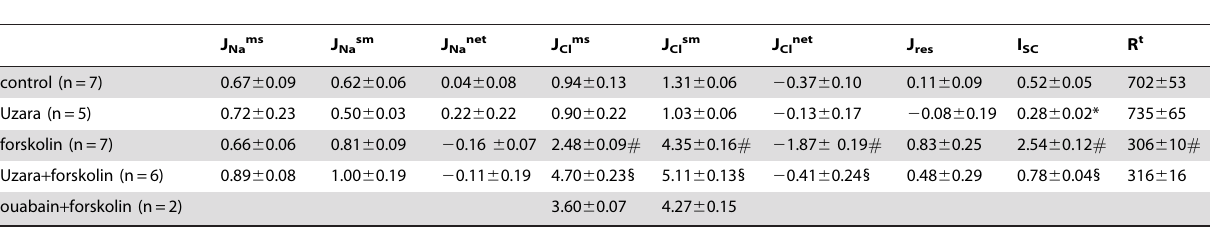
Table 1. Influence of Uzara and forskolin on Na + and Cl 2 fluxes in HT-29/B6 cells.